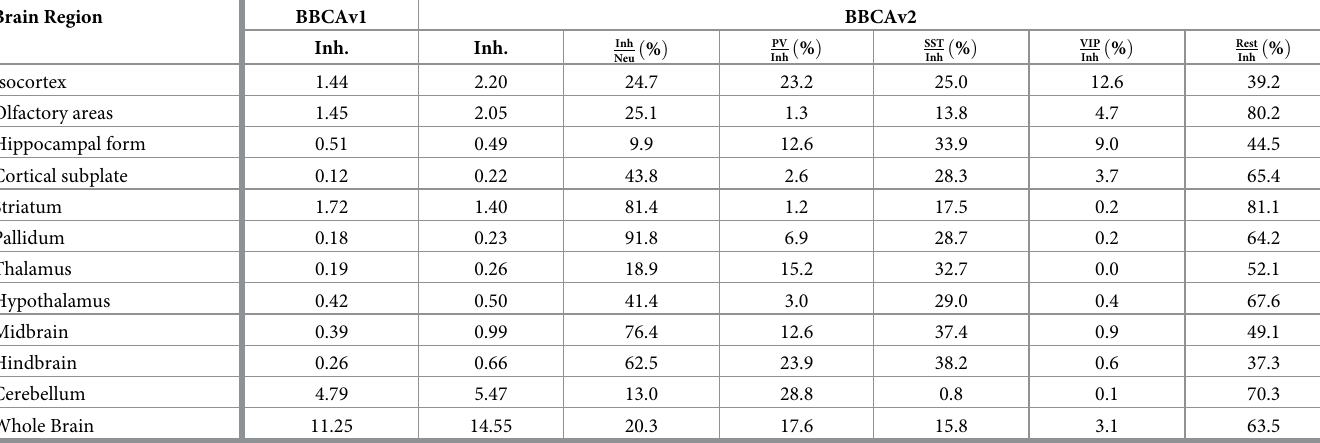
Compared to BBCAv1 (Fig 7B), the number of inhibitory neurons in BBCAv2 (Fig 7C) is larger in almost all regions of the brain (except notably, the hippocampal formation and the striatum). The estimated number of inhibitory neurons in the cerebellar cortex granular layer increases from 203,000 in the previous pipeline to 867,000. Similarly in the isocortex, this number rises roughly by 53% (see S2 Excel). Finally, the BBCAv2 estimates 2.05 million inhibi- tory neurons in the olfactory areas. Table 3. Estimates of inhibitory neurons in the mouse brain in millions and percentage (%) subtypes. Brain Region BBCAv1 BBCAv2 Inh. Inh.